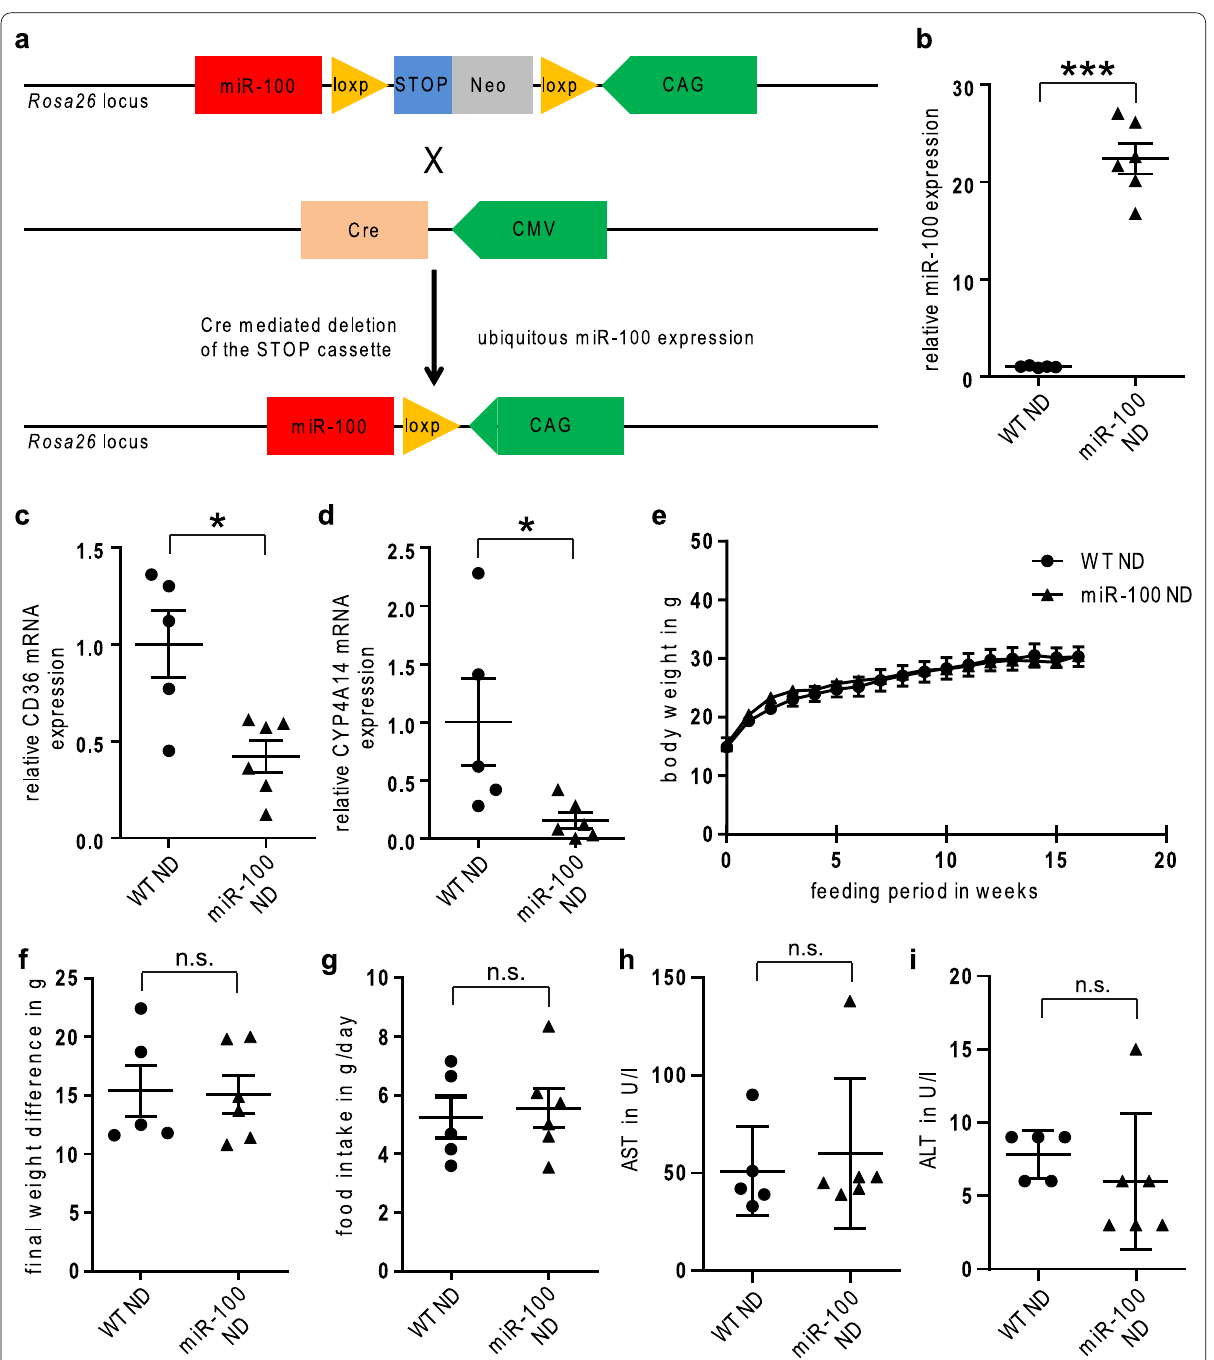
Fig. 1 No obvious phenotypic changes in miR-100 overexpressing mice under normal chow diet (ND). a The schematic illustration of our miR-100 breeding strategy is shown. b The applied breeding scheme resulted in a ~ 22 fold overexpression of miR-100 in liver tissue of transgenic mice as identified using stem-loop based realtime PCR. c , d CD36 and Cyp4a14 were significantly downregulated in liver tissue of transgenic miR-100 mice compared to WT control as analyzed using quantitative real-time PCR analysis. e , f The gain in weight was similar in miR-100 mice compared to WT animals under normal chow diet. g The food intake in ND was comparable in WT and miR-100 mice. h , i No significant changes in serum aspartate (AST) and alanine (ALT) transaminases. (n 5–6 for all experiments) Data represent mean values with SEM. n.s . not significant, *P < 0.05 = and ***P < 0.001 vs. the corresponding